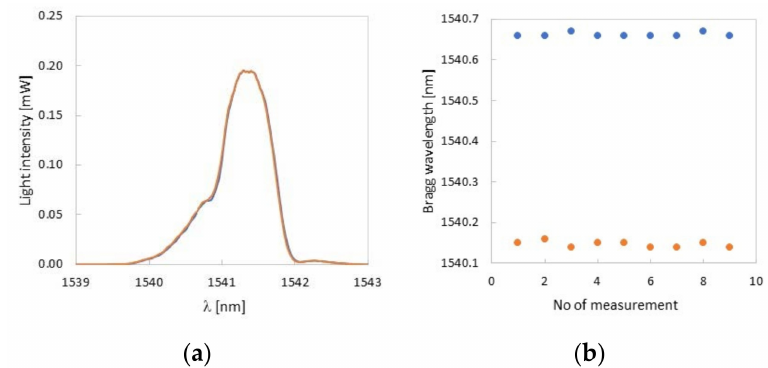
Figure 11. Measurement repeatability test ( a ) and time stability test ( b